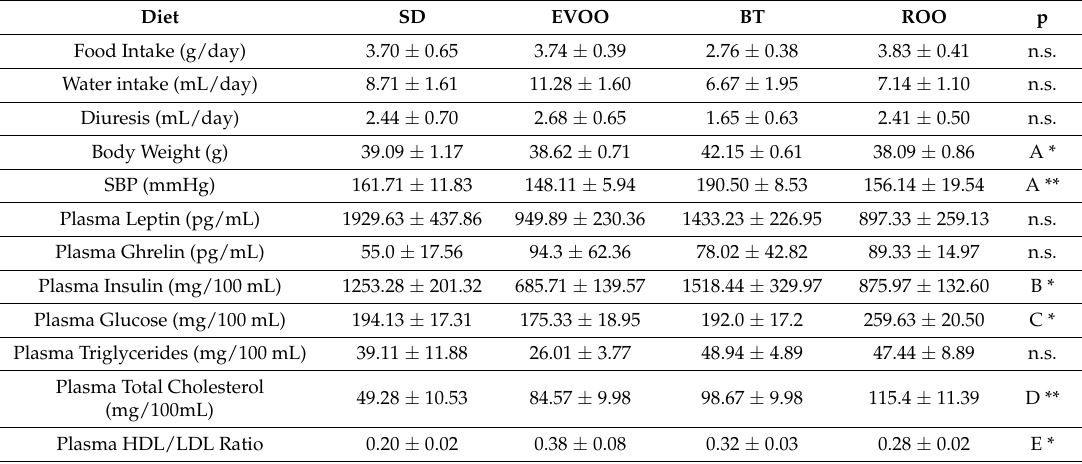
Table 2. Metabolic and physiological values in mice at the end of the